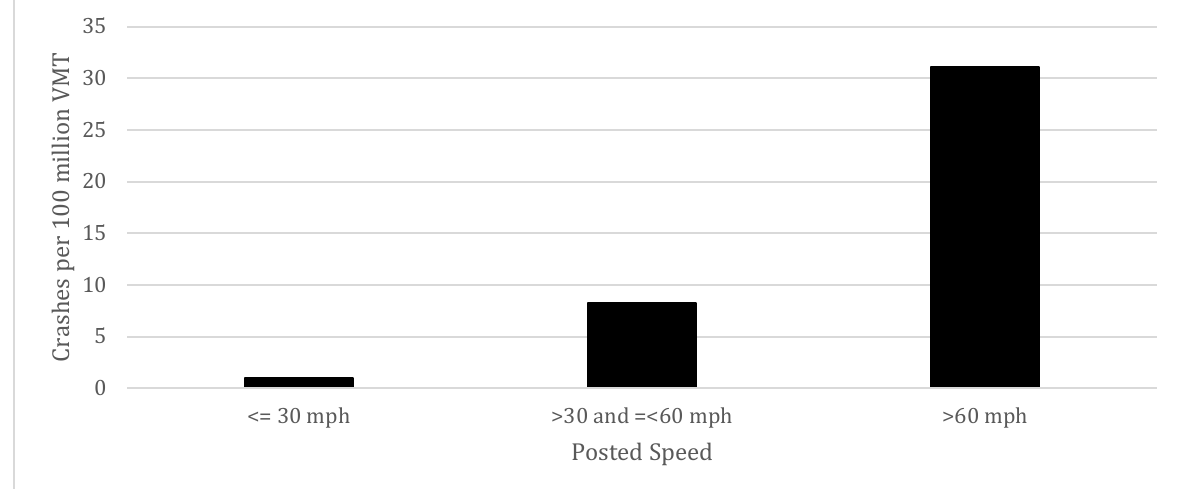
Figure 4 (b): Rate of animal-vehicle crashes based on posted speed